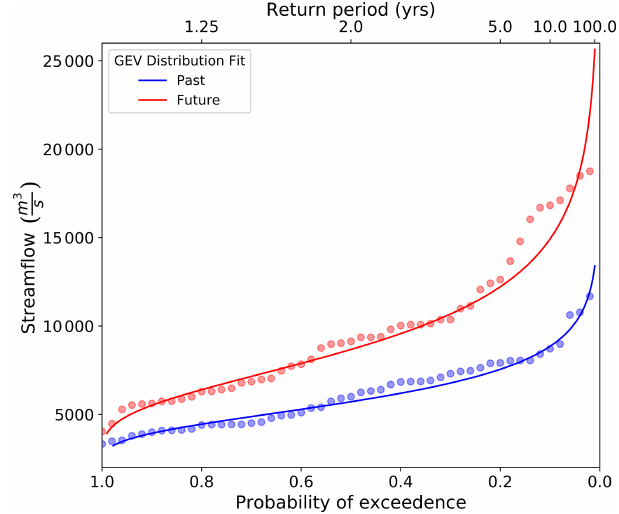
Figure 2. Generalized extreme value (GEV) fit of annual maximum daily streamflow from 50 years of simulation using output from one GCM (HadGEM2-ES) and one hydrologic model (PRMS) for the Willamette River at Portland. Blue and red dots and lines indicate the annual values and GEV fit for the 1950–1999 “past” and 2050– 2099 “future” periods,